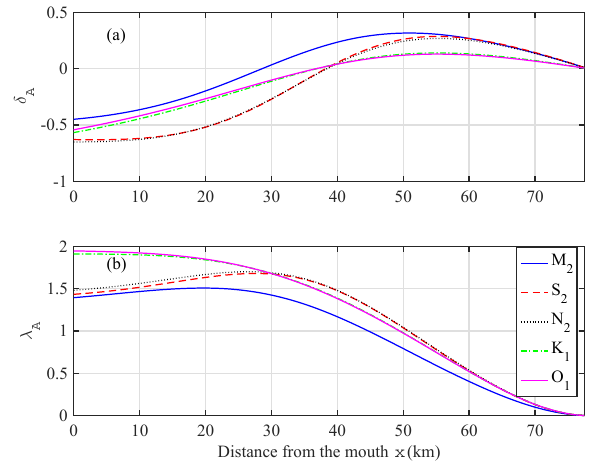
Figure 7. Longitudinal variations in tidal damping/amplification number δ A (a) and wave celerity number λ A (b) for different tidal constituents along the Guadiana